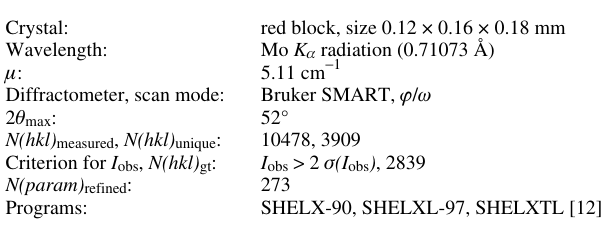
Table 1. Data collection and handling.